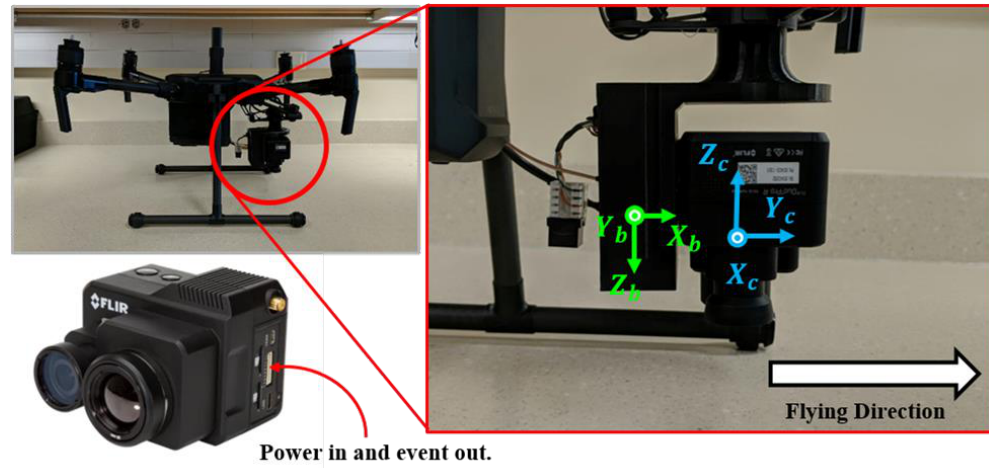
Figure 8. M200-based thermal / RGB system Figure 8 . M200-based thermal/RGB system configuration .